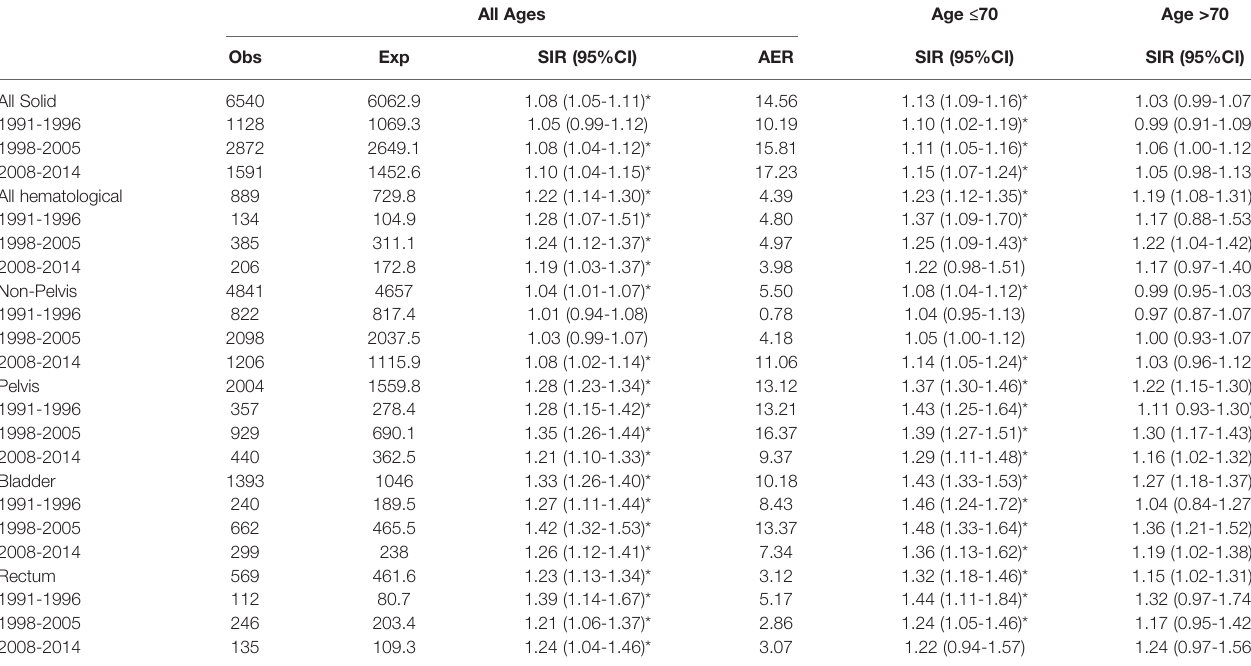
TABLE 2 | SIRs and AER (per 10,000 person years) for PCa patients treated with EBRT +/- hormonal therapy for different time periods and age